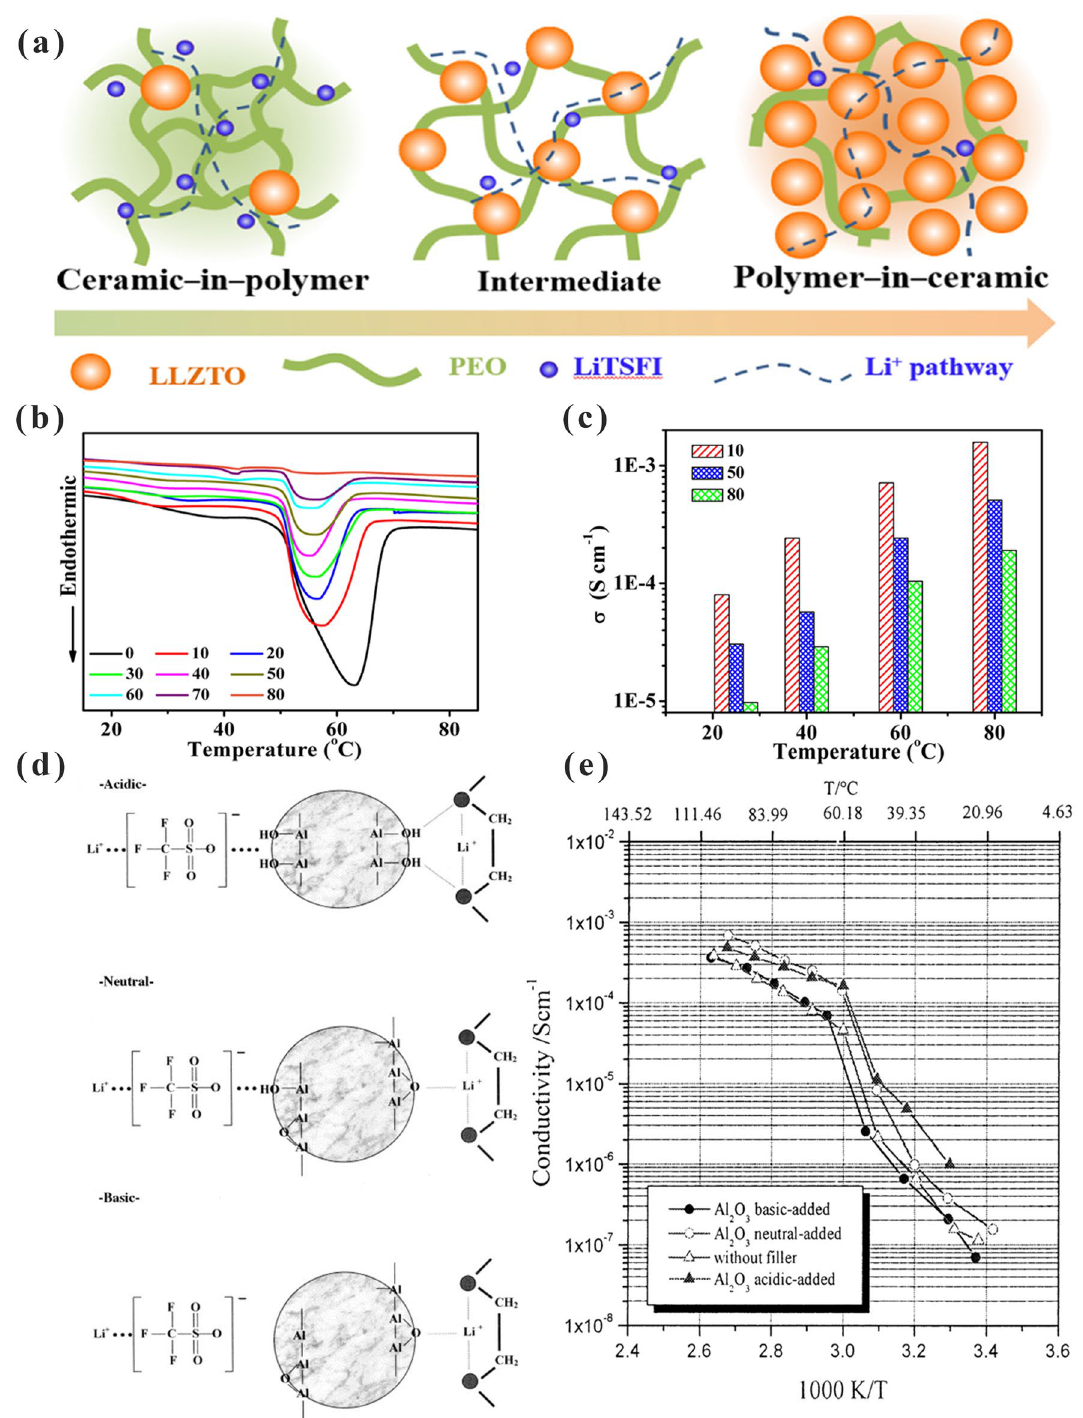
Fig. 3 a Schematic illustration for LLZTO- PEO CPEs; b DSC result of different filler contents of LLZTO-PEO CPEs; c Ionic conductivities of different filler contents of LLZTO- PEO CPEs. Adapted with permission from Ref. [103]. d Surface interactions between three different type Al 2 O 3 and PEO; e conductivity plots of Al 2 O 3 -PEO CPEs. Adapted with permission from Ref.